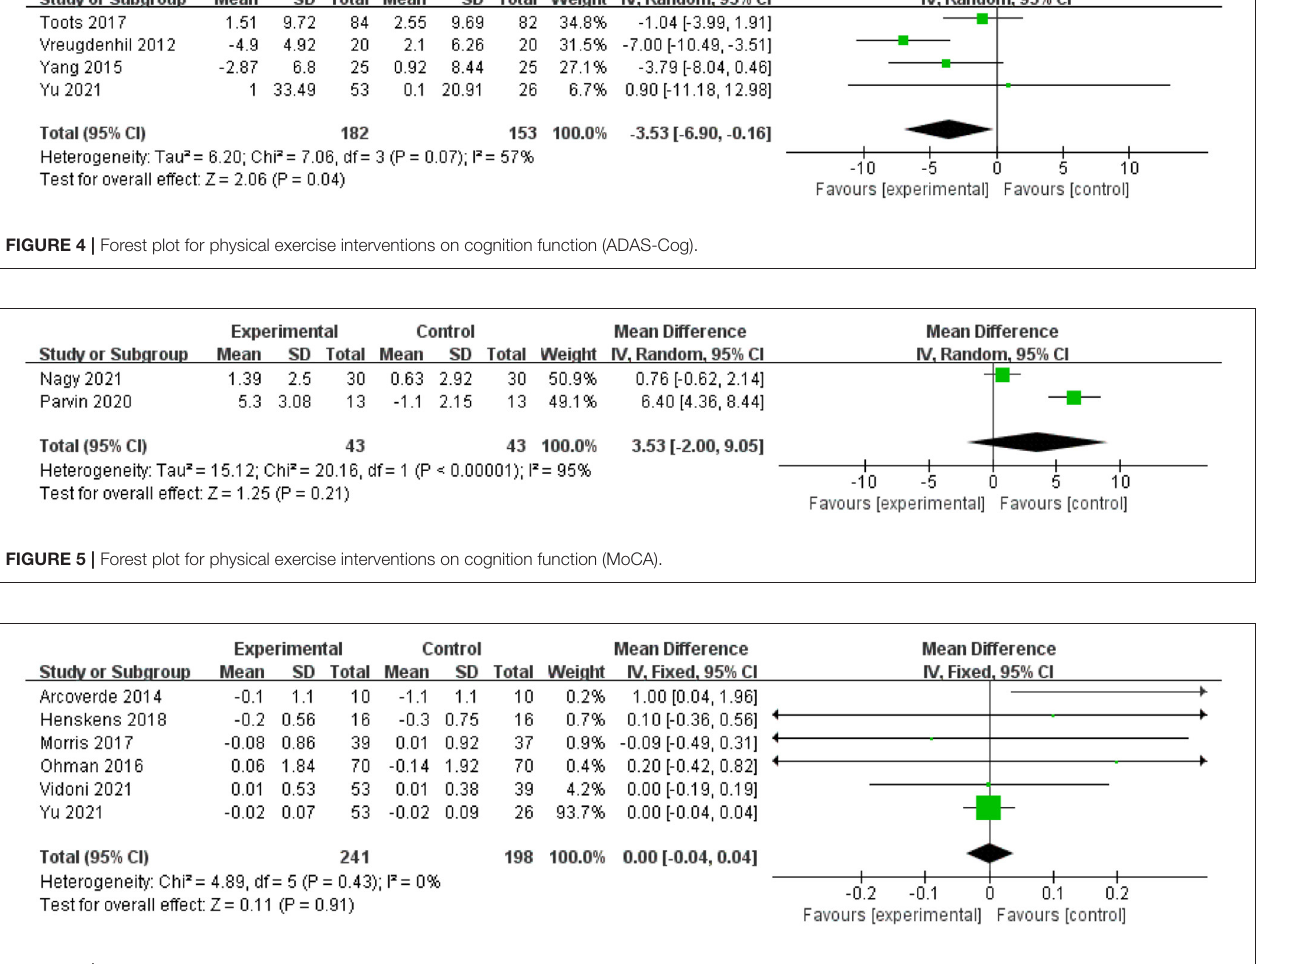
FIGURE 6 | Forest plot for physical exercise interventions on execution